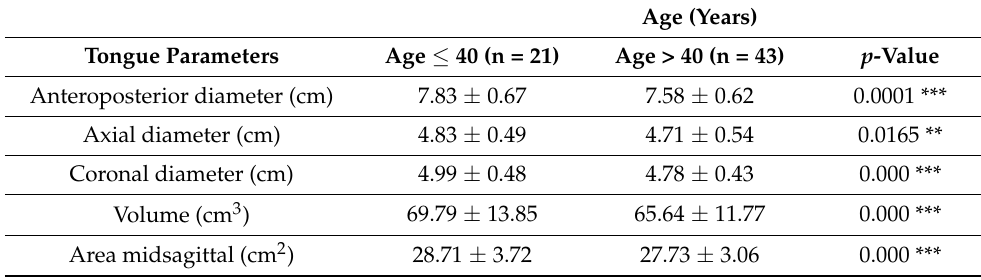
Table 4. MRI parameters of the tongue depending on age. The parameters show the mean ± SD values. *** indicates the significant difference at p < 0.01 level, whereas ** the significant difference at p < 0.05 level. Only the significantly different parameters are shown in the